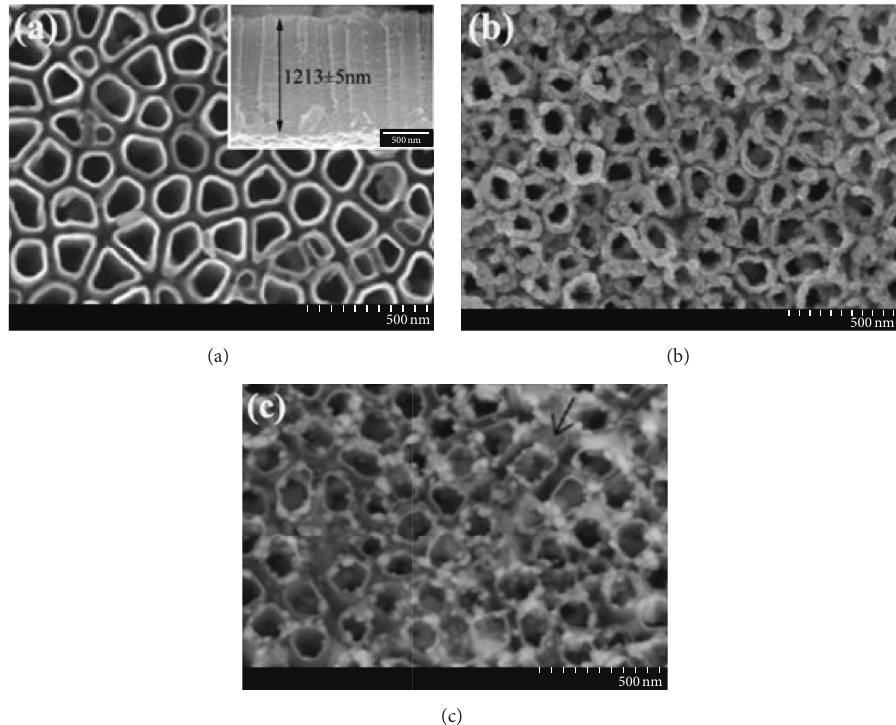
Figure 1: SEM images of TiO 2 (a), Ag-TiO 2 (b), and Ag-TiO 2 (500 ∘ C) (c) nanotube. Inset: the sectional view of TiO 2 .